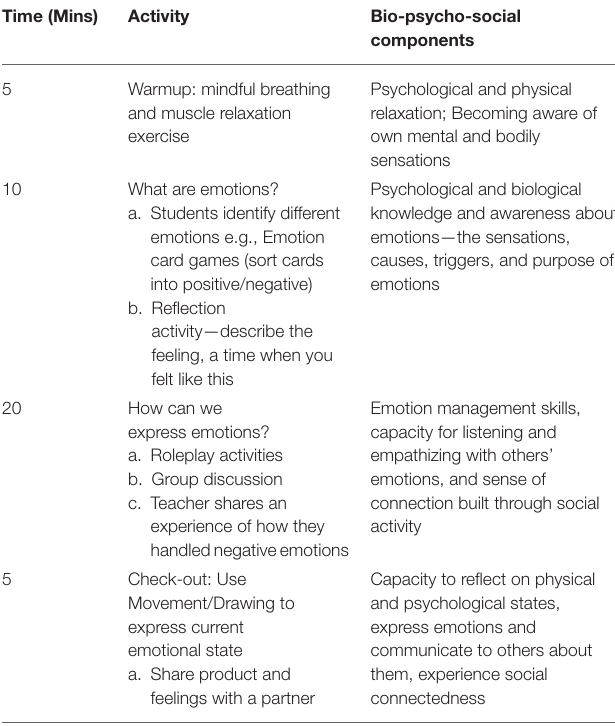
TABLE 3 | Example of basic rundown for session 1 “understanding emotions” with bio-psycho-social components. Time